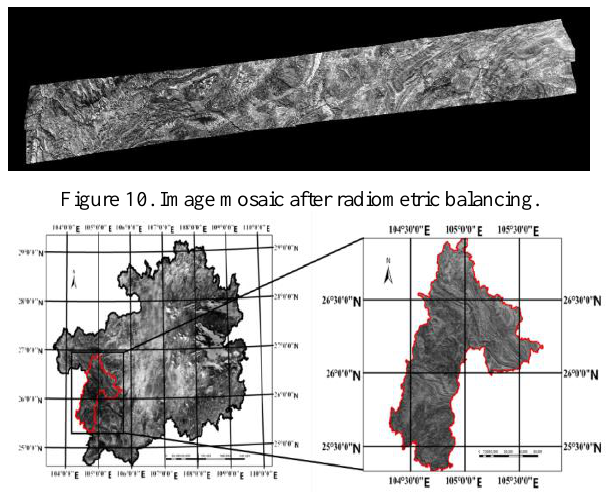
Fig.11 High Resolution Panchromatic Image of Liupanshui in